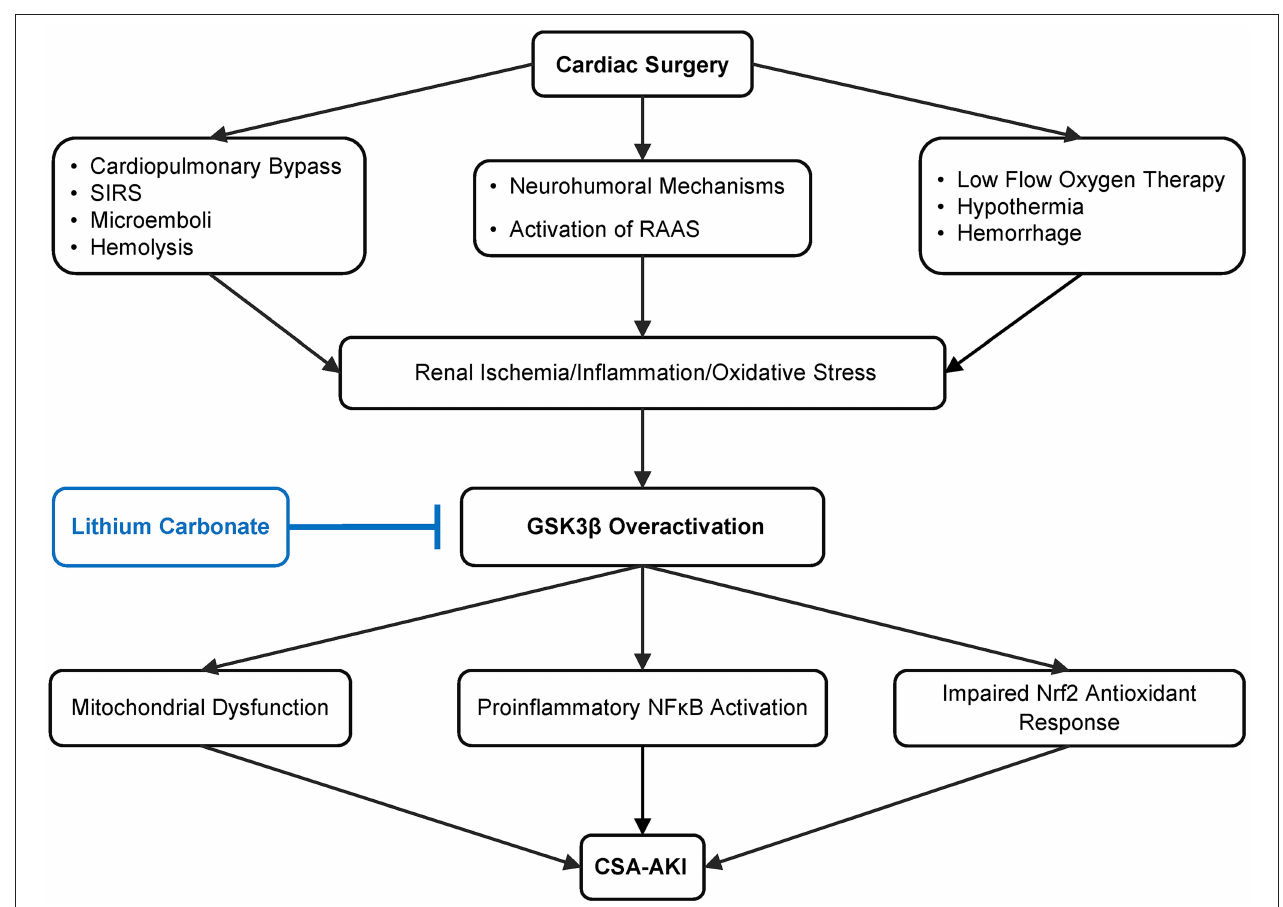
FIGURE 1 | Schematic diagram depicting pathways leading to cardiovascular surgery-associated acute kidney injury (CSA-AKI) and role of GSK3 β in the pathogenesis. There are multiple, complicated pathways mediating CSA-AKI. Cardiovascular surgery is a state of low blood flow, there is hypothermia, blood loss, activation of renin angiotensin aldosterone system (RAAS). Additionally due to CPB there is hemolysis, systemic inflammatory response syndrome (SIRS) and microemboli formation. Together these lead to reduced renal perfusion, ischemia, increase in oxidative and inflammatory injury, which in turn overactivate GSK3 β . GSK3 β increases proinflammatory NF κ B activation, potentiates mitochondrial dysfunction as well as impairs Nrf2 antioxidant response, culminating in CSA-AKI. As an FDA-approved mood stabilizer, lithium is a standard and effective inhibitor of GSK3 β and is able to ameliorate diverse types of AKI in pre-clinical models. Its efficacy in preventing CSA-AKI will be tested by this prospective, randomized, double blinded, placebo-controlled pilot clinical